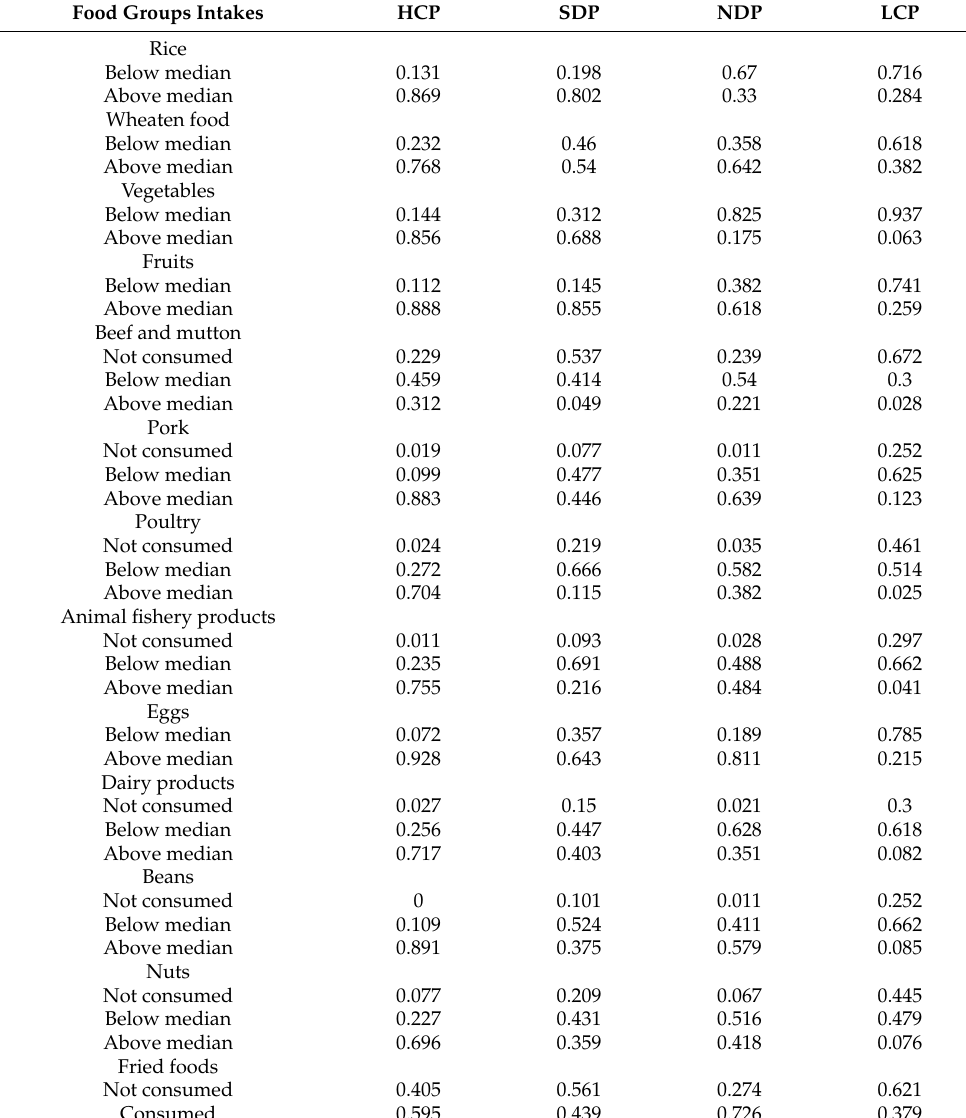
Table 3. Probabilities of the first-trimester food groups intakes derived from LCA,